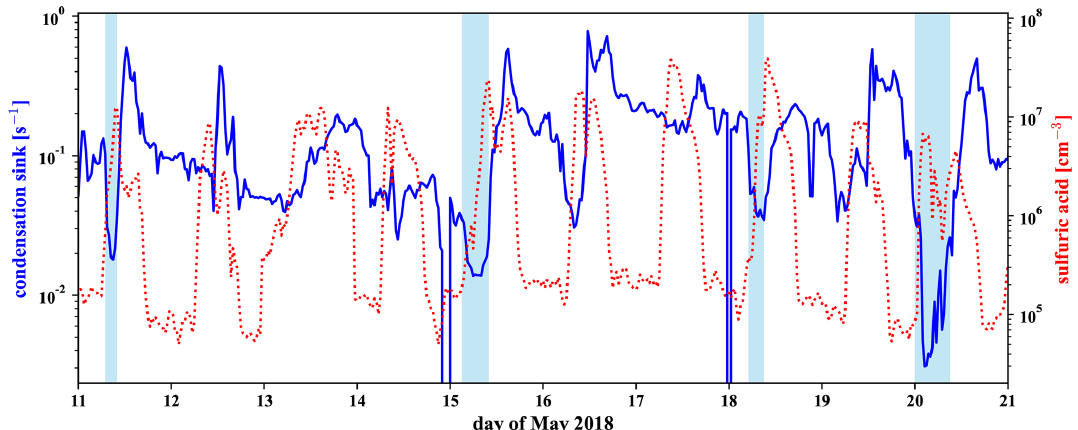
Figure D5. Time series of sulfuric acid in red and of the condensation sink (pressure-corrected) in blue, calculated as described below. Marked in light blue are the identified FT